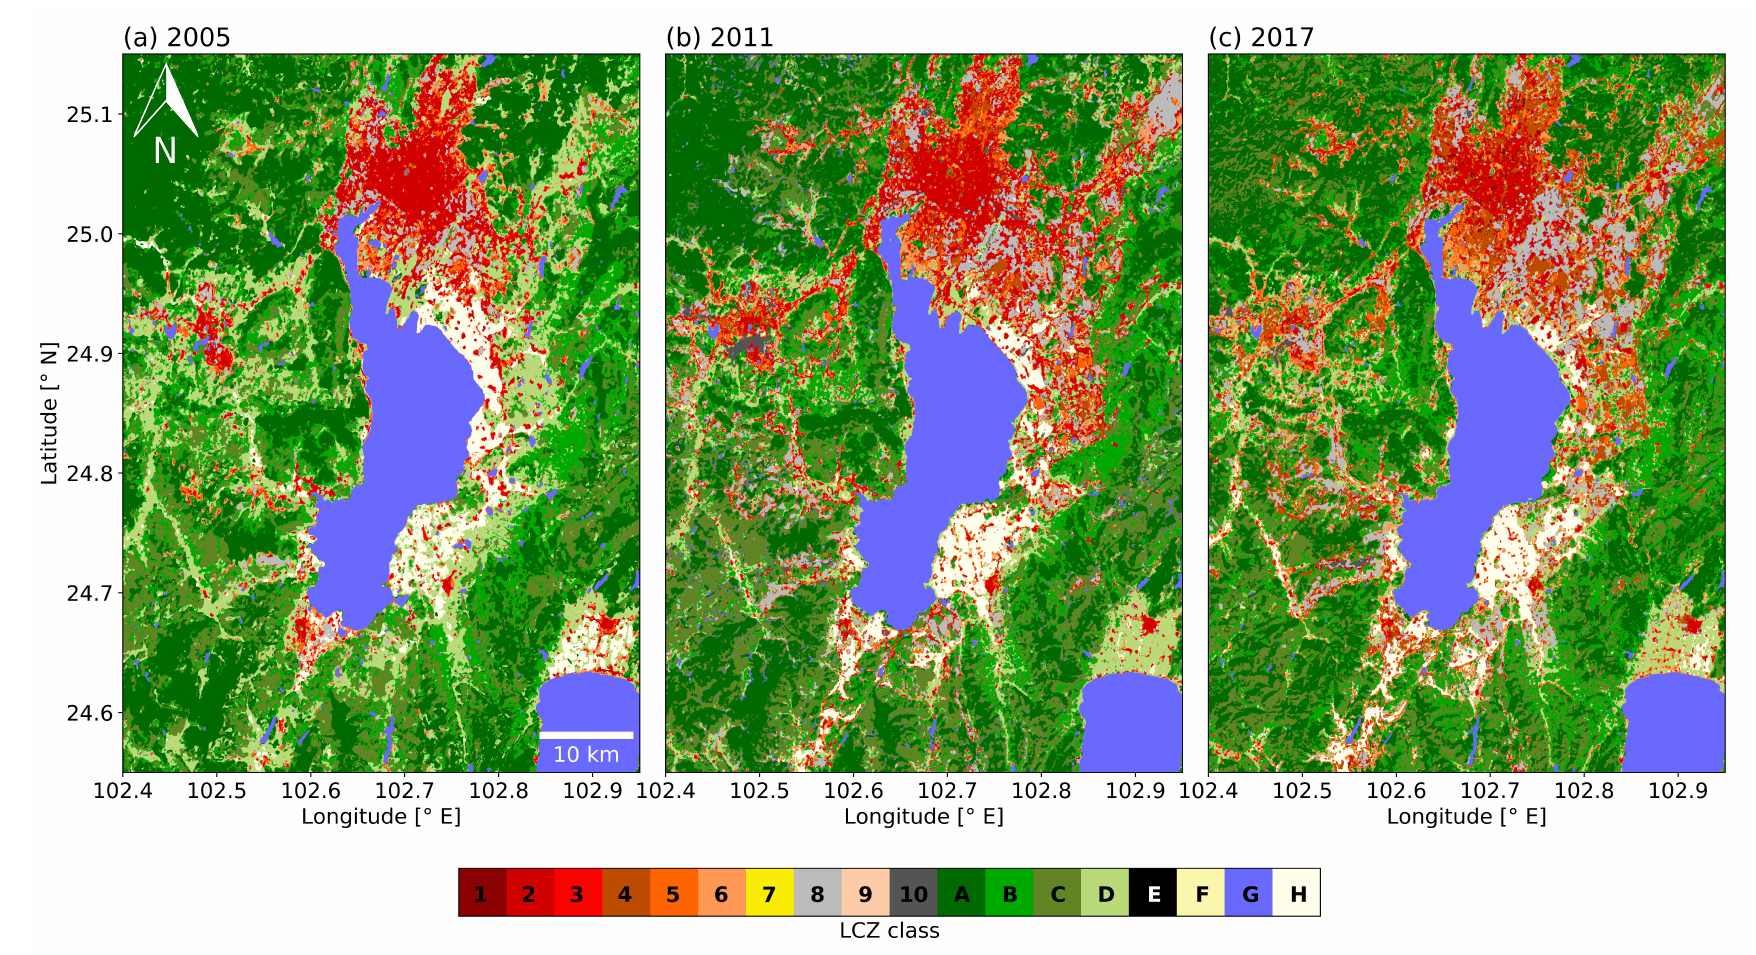
Figure 5. LCZ maps for: ( a ) 2005 with kernel size 9 × 9, ( b ) 2011 with kernel size 5 × 5, and ( c ) 2017 with kernel size 7 × 7. Note that LCZ classes 7, 9, E, and F are not present in the